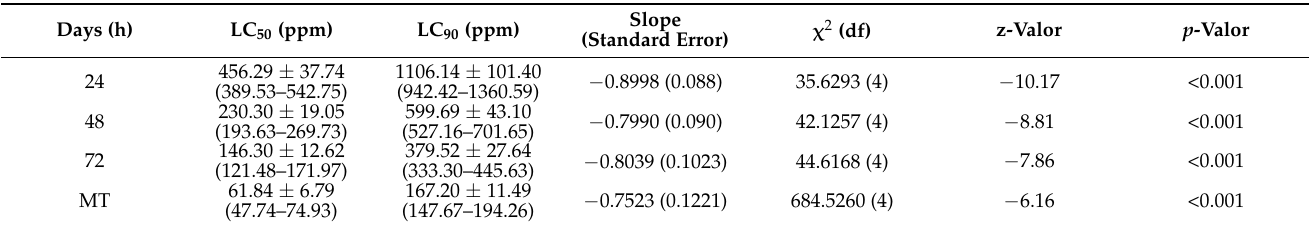
Table 4. Probit linear regression analysis for mean lethal concentrations that control the population of Aedes aegypti mosquitoes treated with Piper cordoncillo essential oil for three consecutive days, and at the end of the 17-day